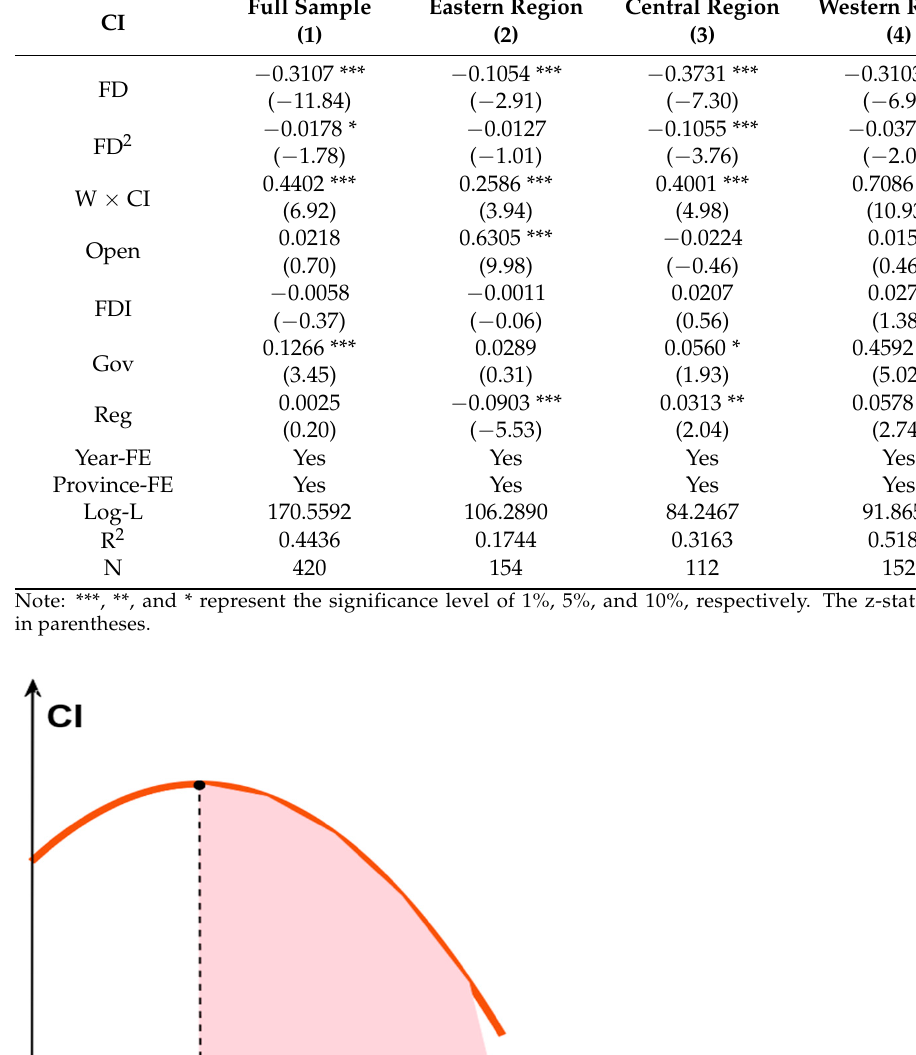
conducive to the reduction of carbon emissions intensity at the present stage. Columns (2)–(4) in Table 4 show the sub-regional estimation results in the non-linear models. The coefficient value of FD 2 in the eastern region is not significant, but